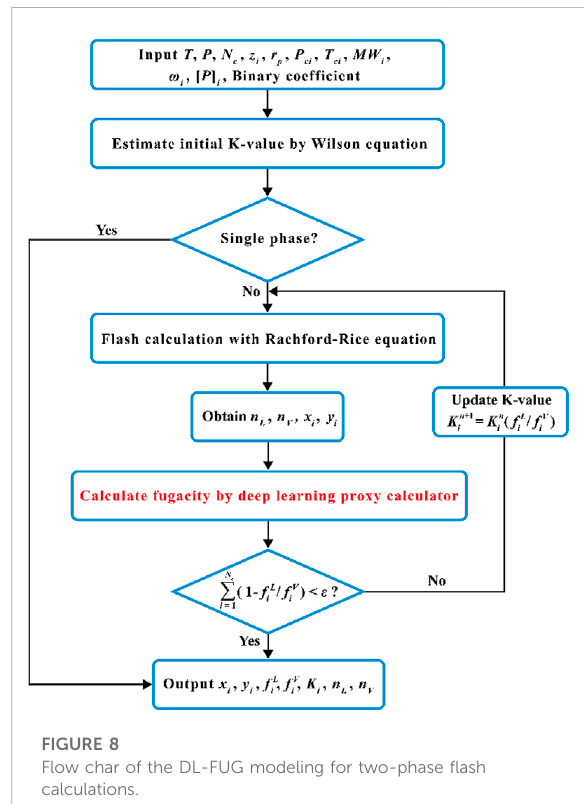
FIGURE 8 Flow char of the DL-FUG modeling for two-phase fl ash